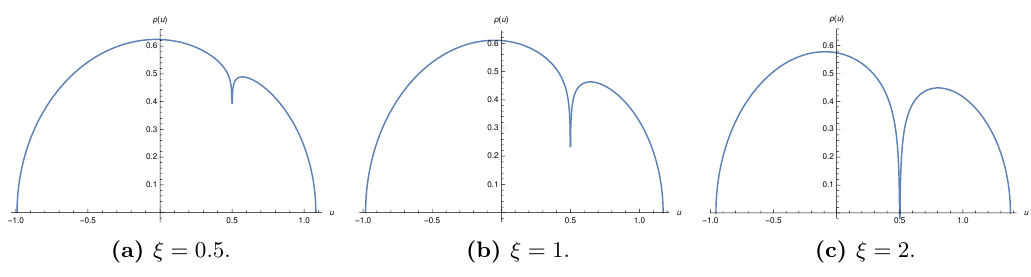
Figure 4 . Plot of the eigenvalue density (cid:26) ( u ) in (4.24) for (cid:18) = (cid:25)= 3 with (a) (cid:24) = 0 : 5, (b) (cid:24) = 1, and (c) (cid:24) =